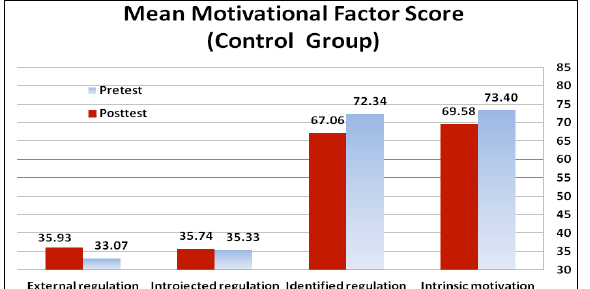
Figure 2. Mean motivational factor score among control group